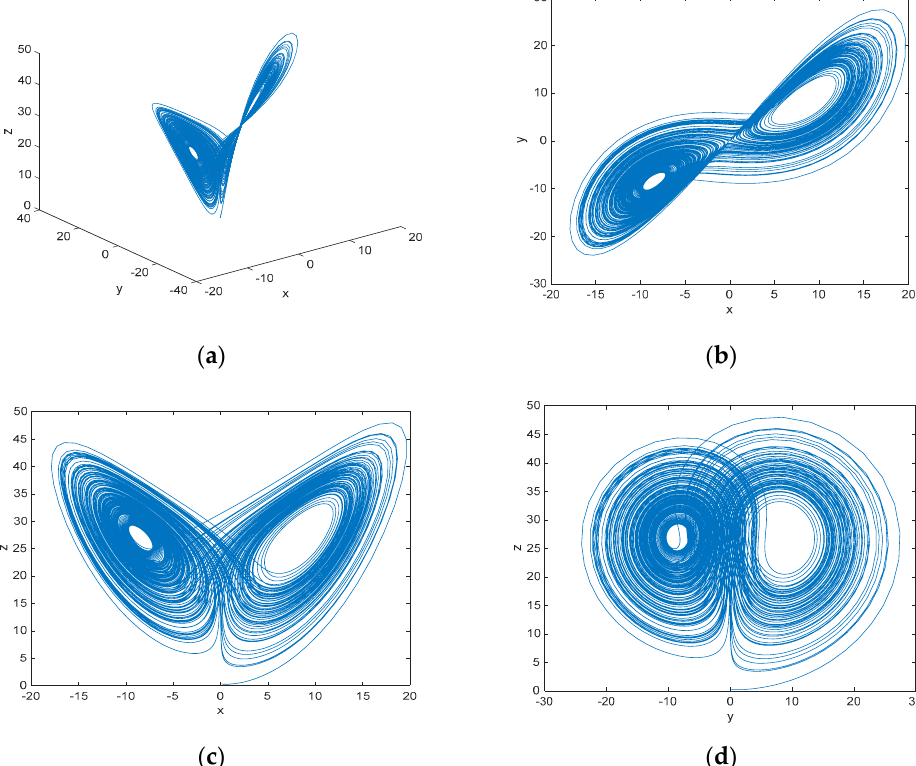
Figure 9. Phase space diagram of each plane. ( a ) x-y-z plane; ( b ) x-y plane; ( c ) x-z plane; ( d ) y-z plane.